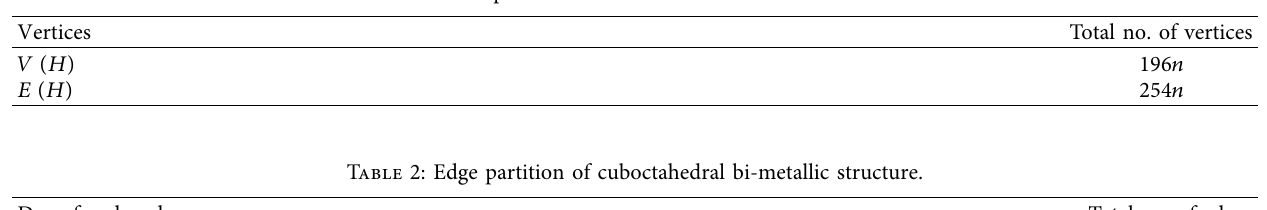
Figure 1: Cuboctahedral bi-metallic. Table 1: Vertex partition of cuboctahedral bi-metallic structure.